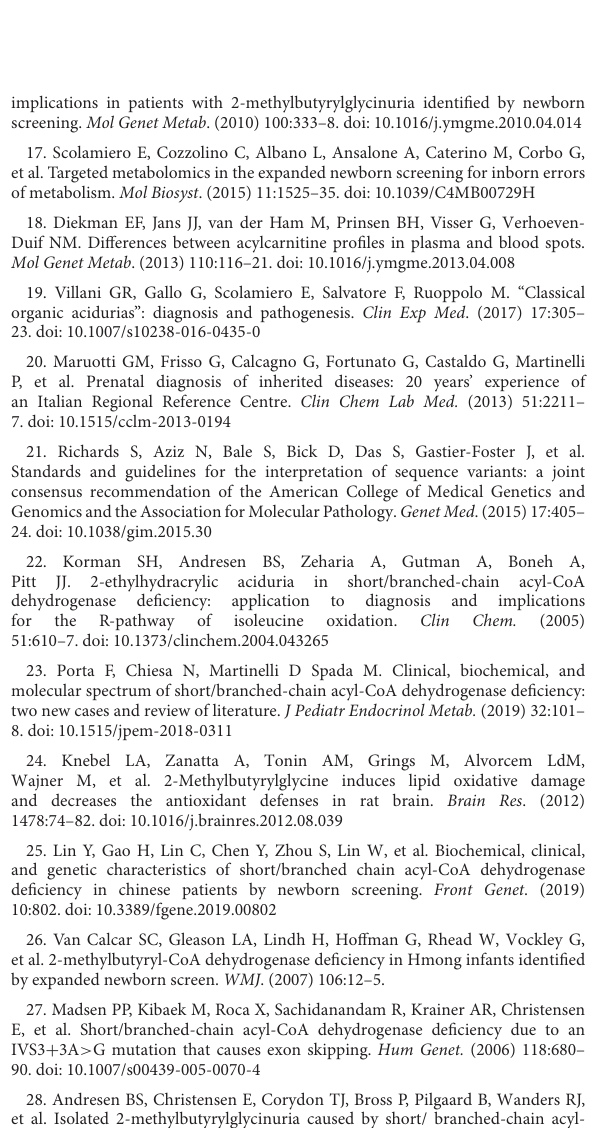
SUPPLEMENTARYFIGURE1 Regional Operative Procedure for newborns suspected with an inherited metabolic disease at newborn screening.